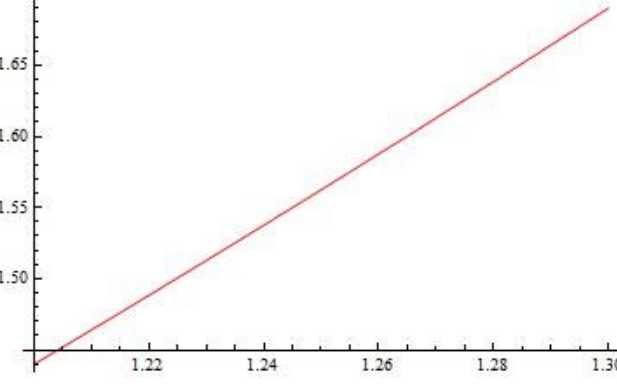
Fig. 5 Graph of the solution using AIM in the interval [ 1 . 2 , 1 . 3 )